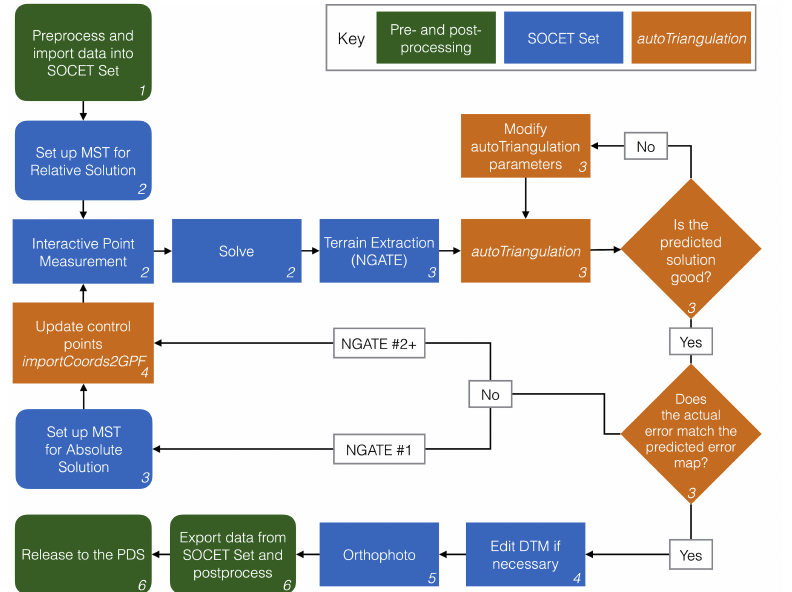
Figure 2. Simplified flowchart of DTM and orthoimage workflow. Numbers correspond to subsec- tions in Section 2.1. There are circumstances when this workflow would be modified, or iterated on more than once or twice, but the decision path and steps are essentially those followed at the HiRISE Operations Center